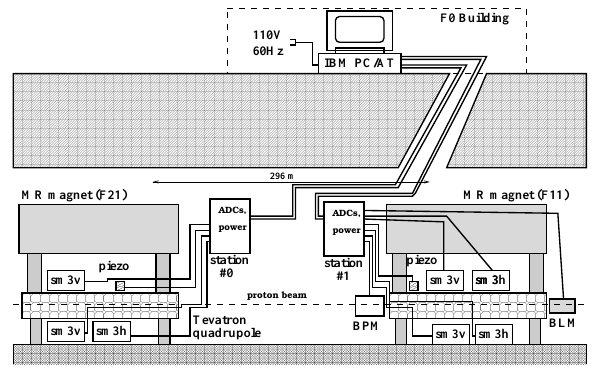
FIG. 2. Measurements in the main ring tunnel. The Tevatron ring is located under the main ring magnets.